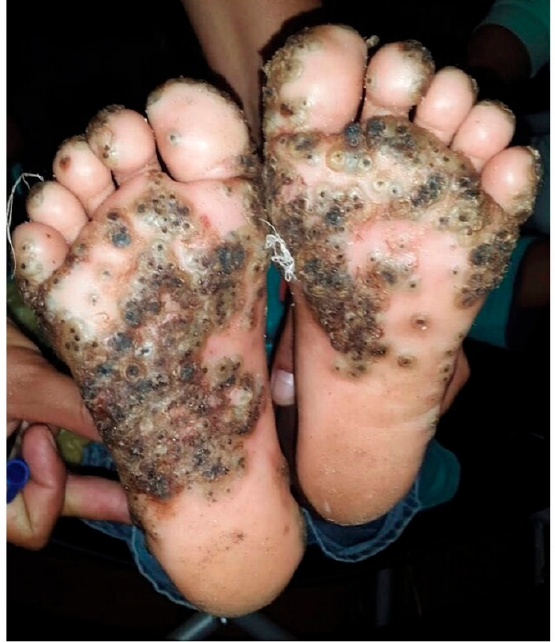
Figure 1. Severe tungiasis in the feet of a 10-year-old girl. Adapted from Barbosa and Barbosa [9]. License Number: 4832790723180.